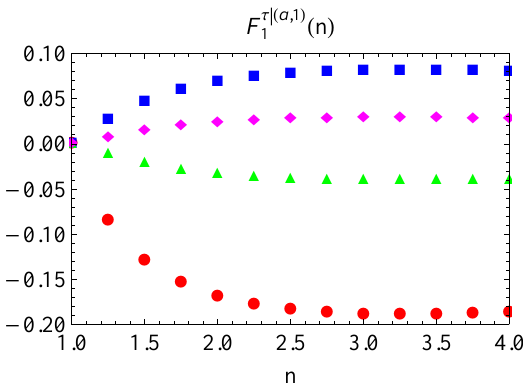
Figure 4: One particle form factors associated to particle 1 (circles), particle 2 (squares), particle 3 (triangles) and particle 4